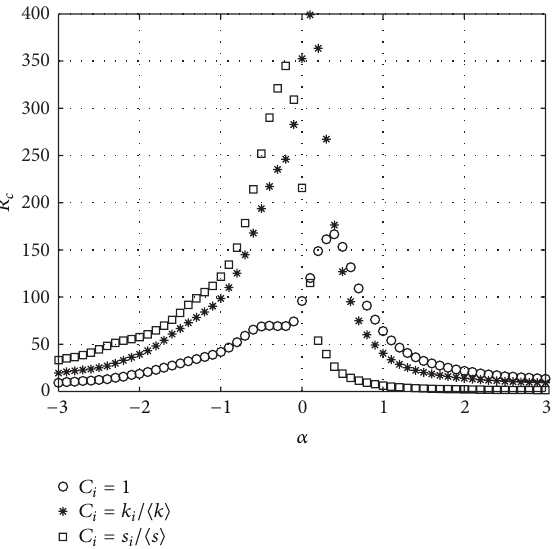
Figure 3: 𝑅 𝑐 versus 𝛼 . BBV network with 𝑛 = 1000 , 𝛿 = 6 , 𝑚 = 3 , and 𝜔 0 = 1 .